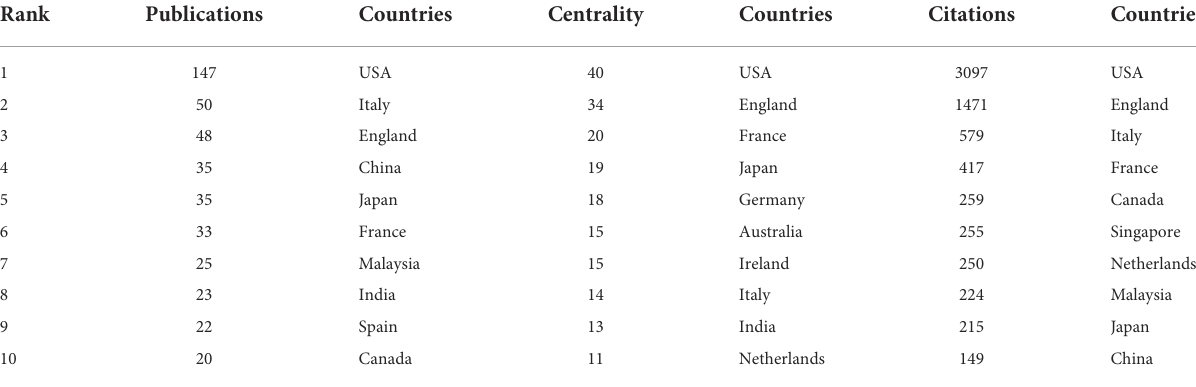
TABLE 3 Top 10 publications, centrality and citations of countries related to AI on ASD.